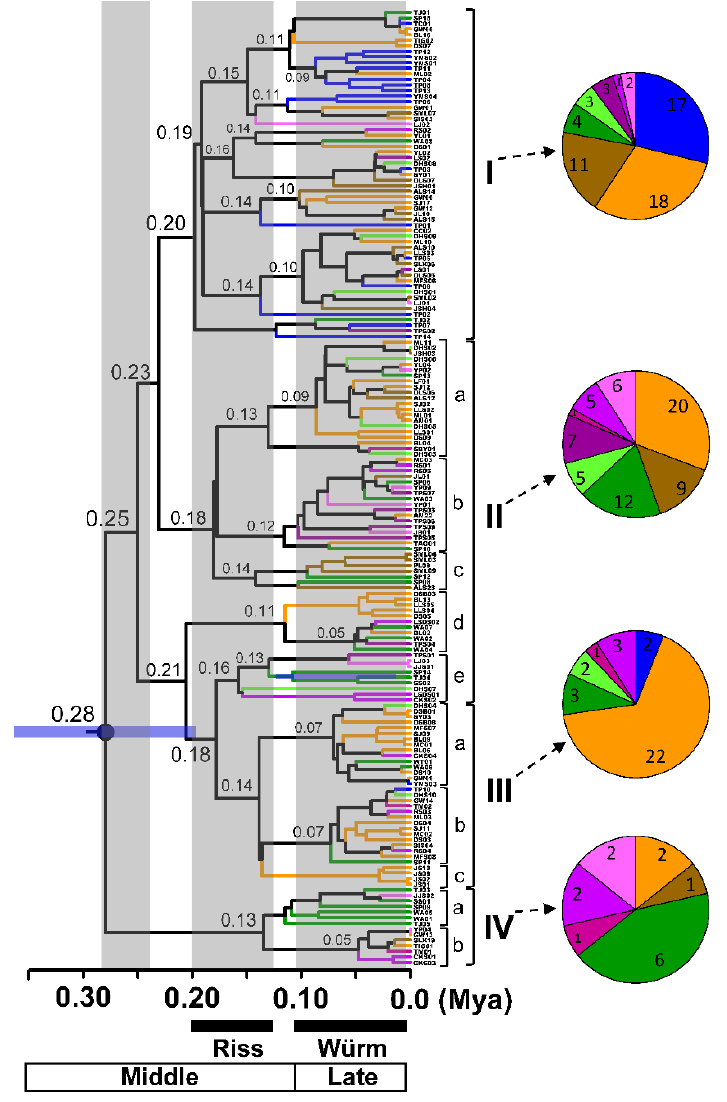
Figure 2. Calibration dating of the hilly lineage of NSC based on cytochrome oxidase subunit I (COI) + 16S rRNA genes. Populations denoted with different colors are the same as those in Figure 1. Pleistocene glaciation events are shaded in gray and labeled at the bottom [40].